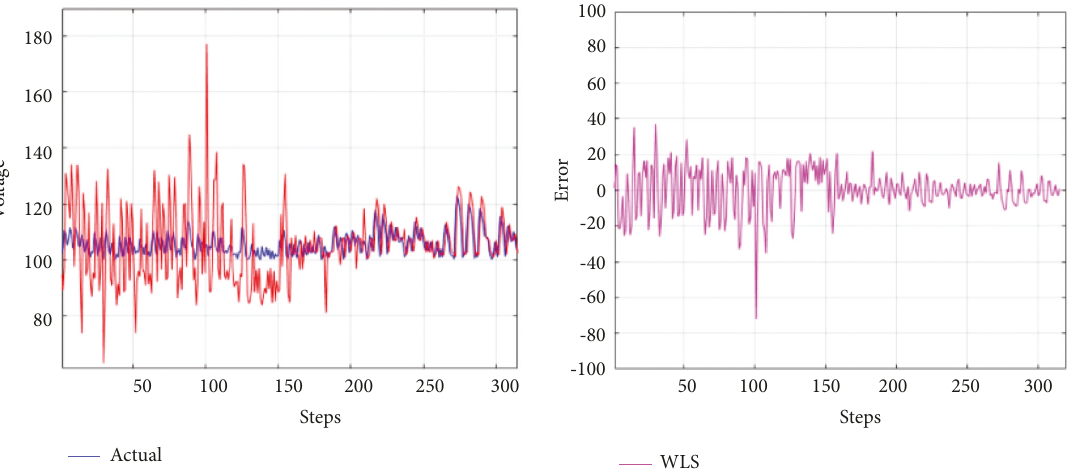
Figure 10: Estimation by WLS.